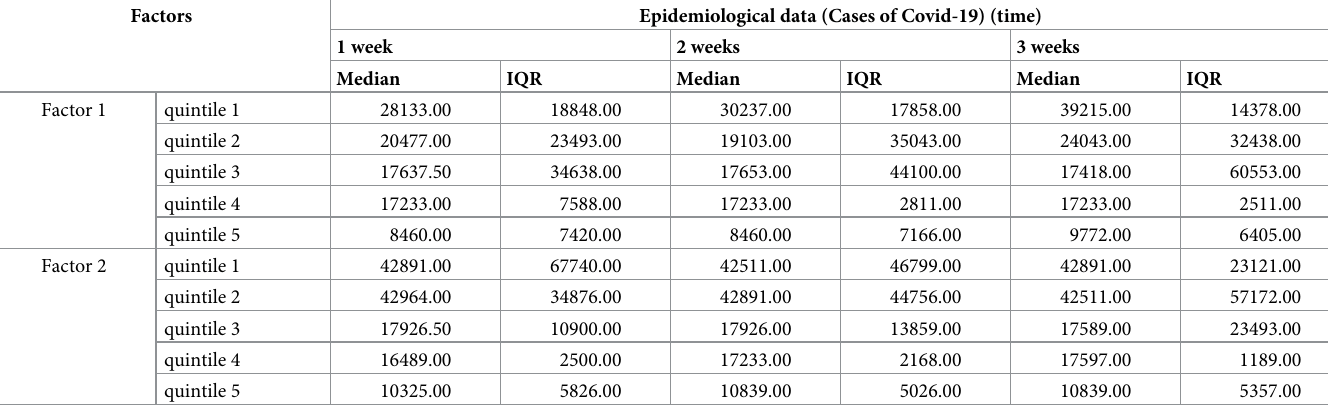
Table 1. Mean and IQR of factor score 1 and factor score 2 based on quintiles. Factors Epidemiological data (Cases of Covid-19)